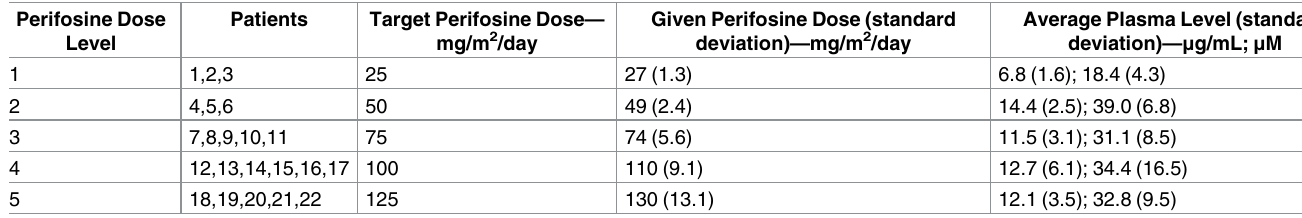
Table 8. Perifosine